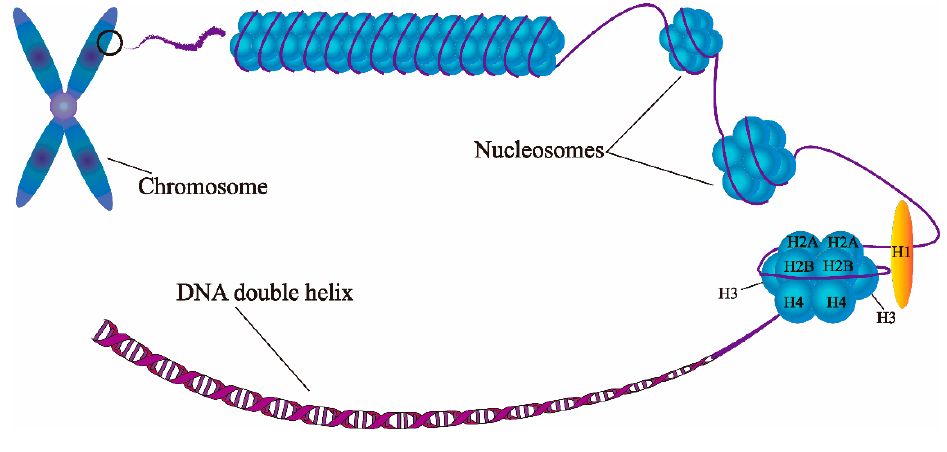
Figure 2. A model of chromatin.